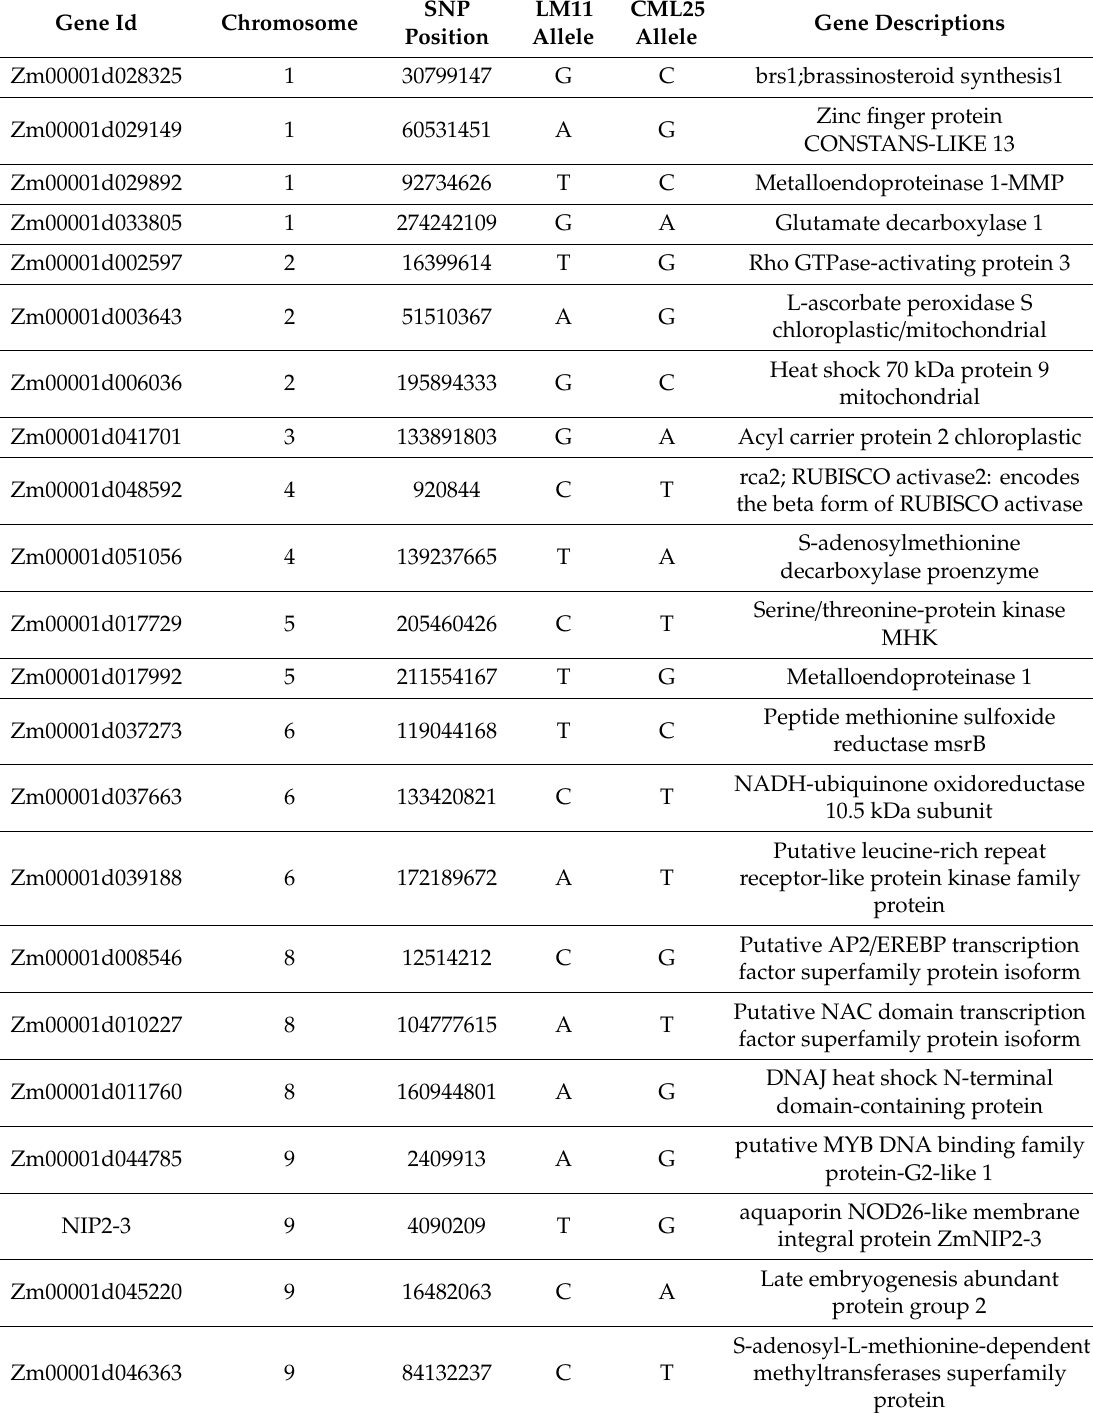
Table 4. Heat stress response (HSR) genes with SNP variants in LM11 and